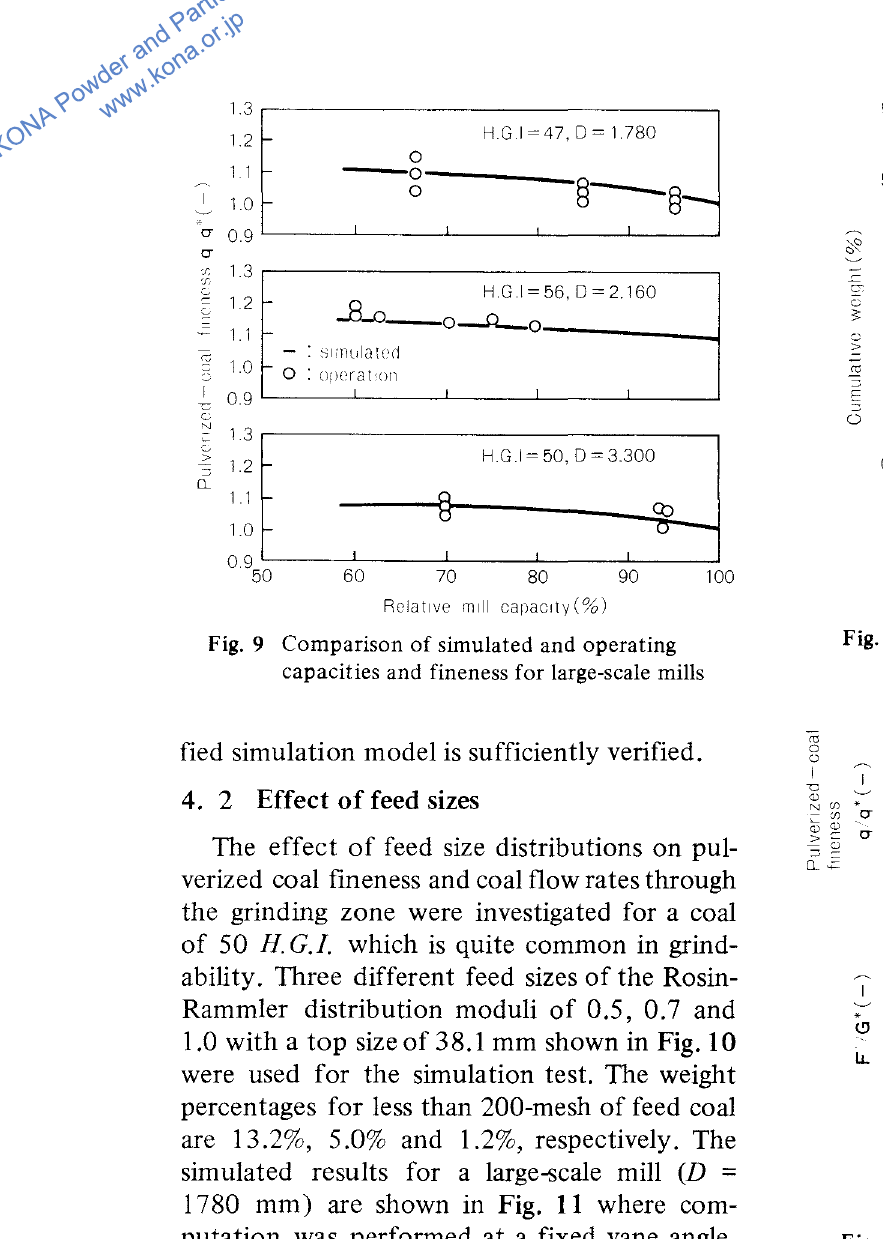
Fig. 11 Effect of feed size on mill performance (simulation)